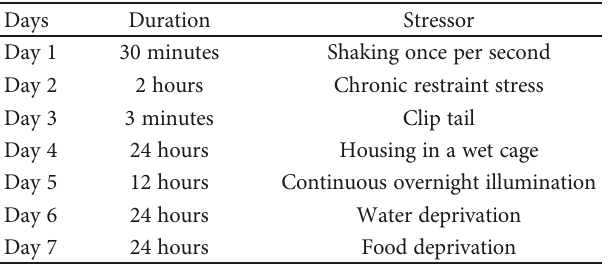
Table 1: The CUMS procedure of applied stressors during 1 week. Days Duration